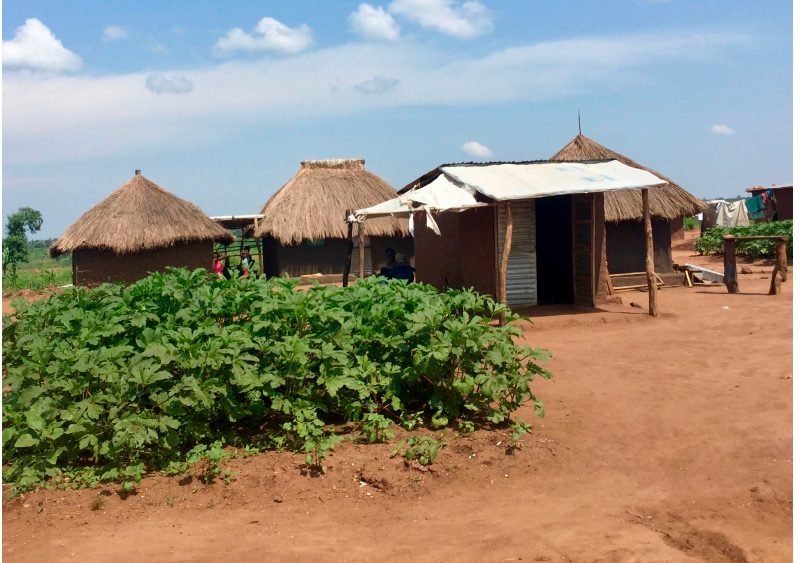
Figure 3. These refugee homes are indistinguishable from the homes of the host community’s residents. In addition to farming their allocated plot, this family has established a small store in front of their homes. Photograph taken by Tim Berke, 2019.